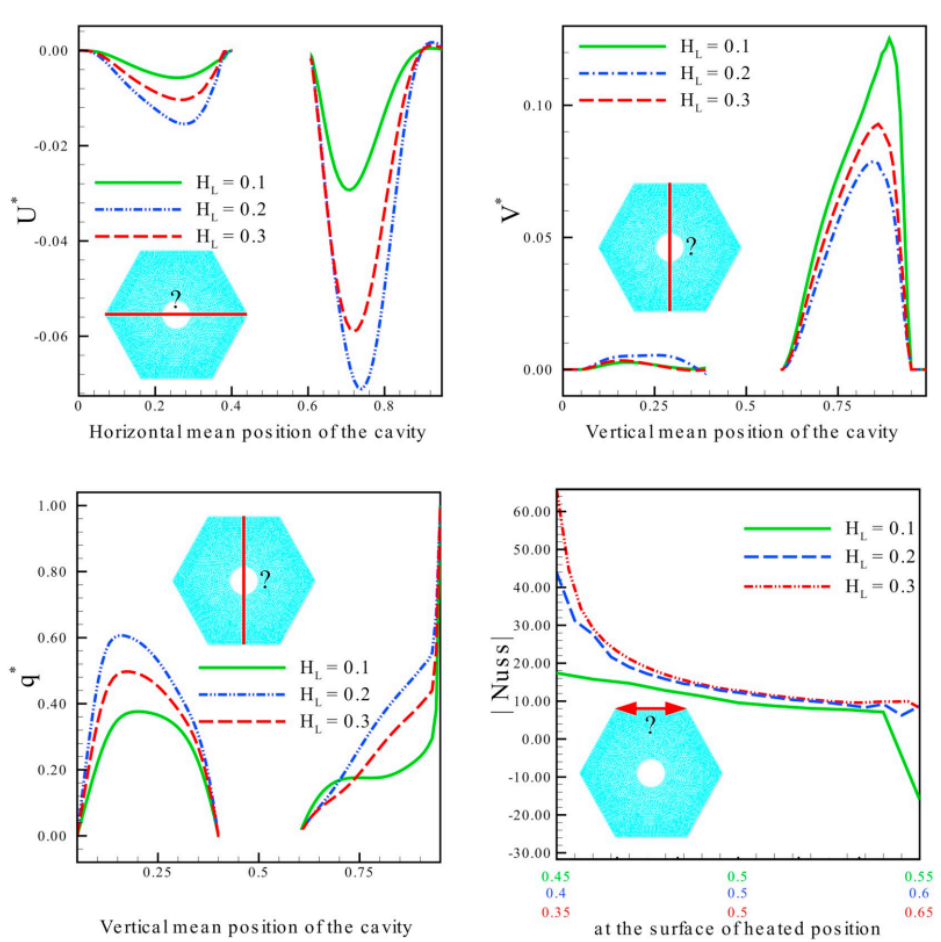
Figure 17. Velocities and temperature variation at mean Nusselt number and position. Reprinted with permission from Ref. [38]. 2020, Elsevier.